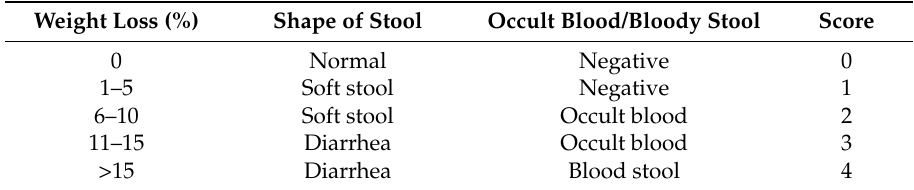
Table 4. Disease activity index (DAI) scoring